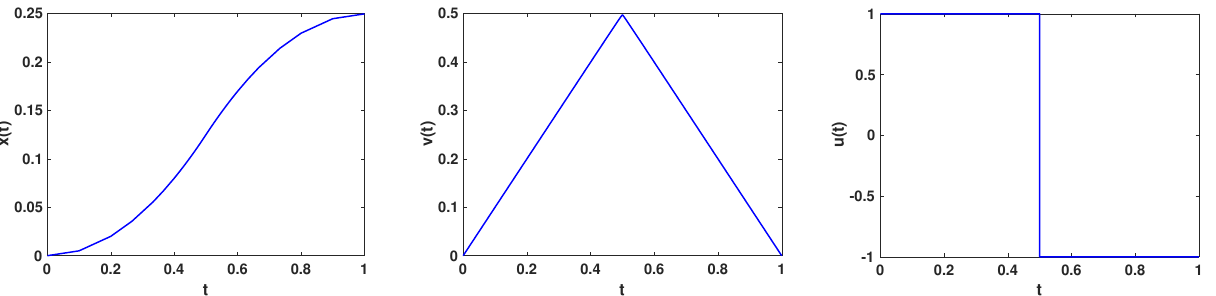
Figure 3. Bang-Bang, (cid:101) = 10 − 3 : solution in time for the mass position x on the ( left ), for the velocity in the ( center ) and the control u on the ( right